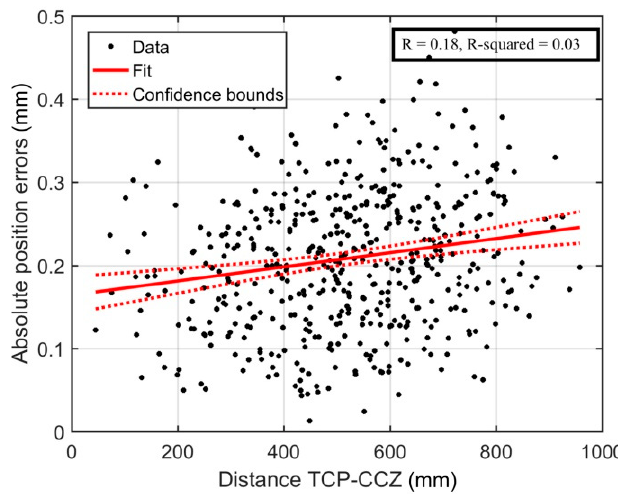
Figure 12. Linear regression-Distance between the TCP and the center of the calibration zone.